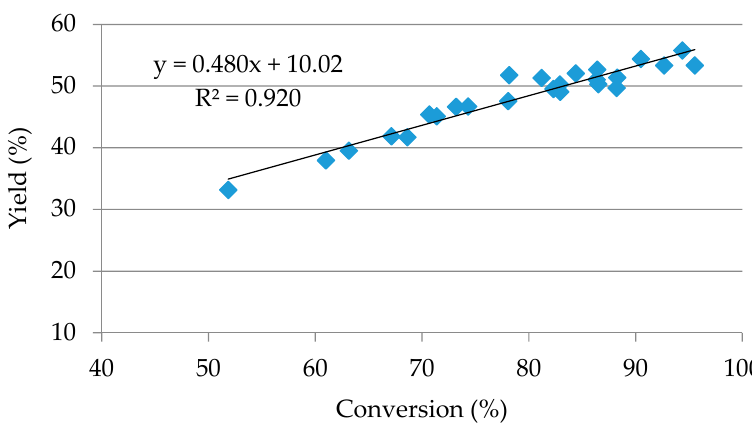
Figure 4. Linear performance regression versus conversion of the values of the composite central design.